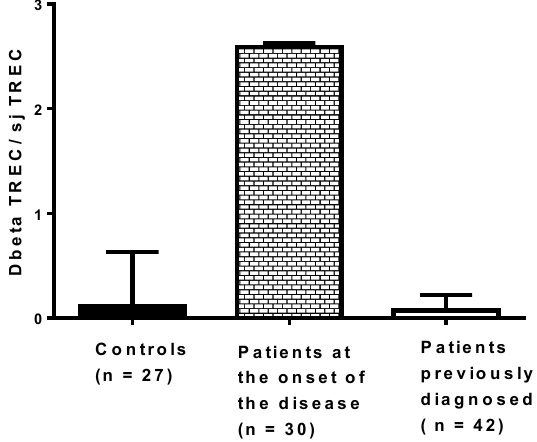
Figure 5. Ratio of D β TREC/sjTREC in newly diagnosed patients, previously diagnosed patients and controls. Type 1 diabetes was diagnosed a few days before collecting blood in patients at the onset of the disease, whereas the disease was diagnosed at least 10 months before collecting blood in the other group of patients.